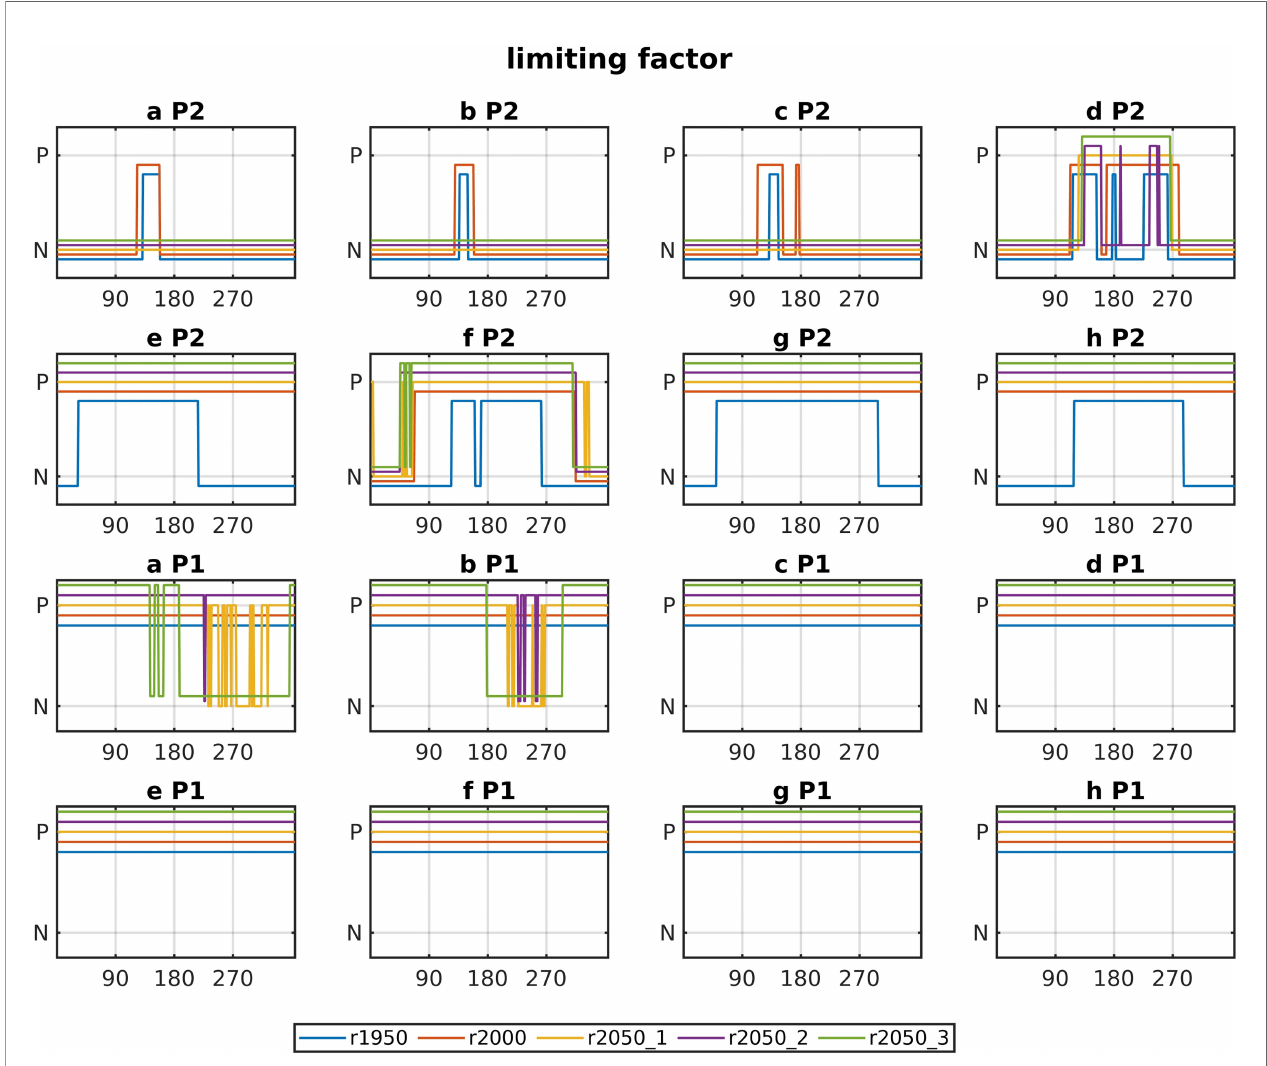
FIGURE 7 | Nutrient limitation of phosphate and nitrate or ammonium (see Section Biological Model and Equation 2.2.1) for all base runs and areas against time. The top two rows are diatoms and the bottom two rows are small